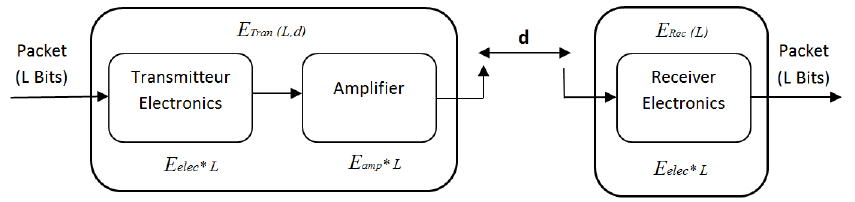
Figure 9. Radio energy consumption